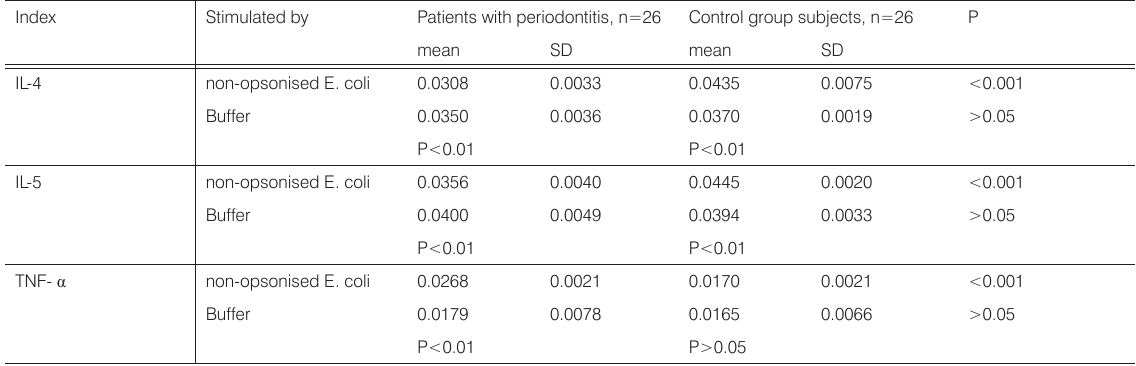
Table 3. IL-4, IL-5, TNF- α levels in peripheral venous blood leukocyte medium stimulated by non-opsonised E. coli and control